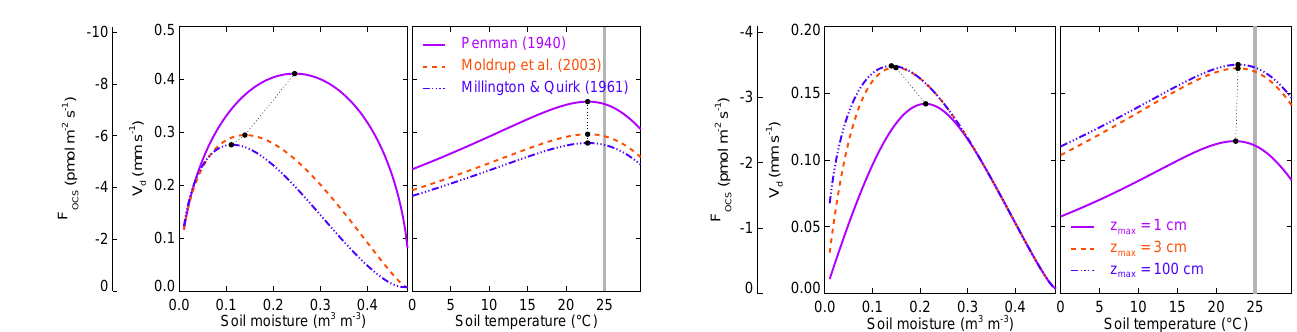
Figure 4. Sensitivity of the modelled OCS flux ( F OCS ) and deposi- tion velocity ( V d ) to soil column depth. The soil moisture and tem- perature response curves shown here were obtained using the diffu- sivity model of Moldrup et al. (2003) and assuming no source term, a soil pH of 7.2 and a CA enhancement factor for OCS hydrolysis of 10000. Closed circles indicate the temperature or soil moisture optimum of each response curve and the grey thick line in the right panel indicates the set optimal temperature for CA activity (25 ◦ C in this